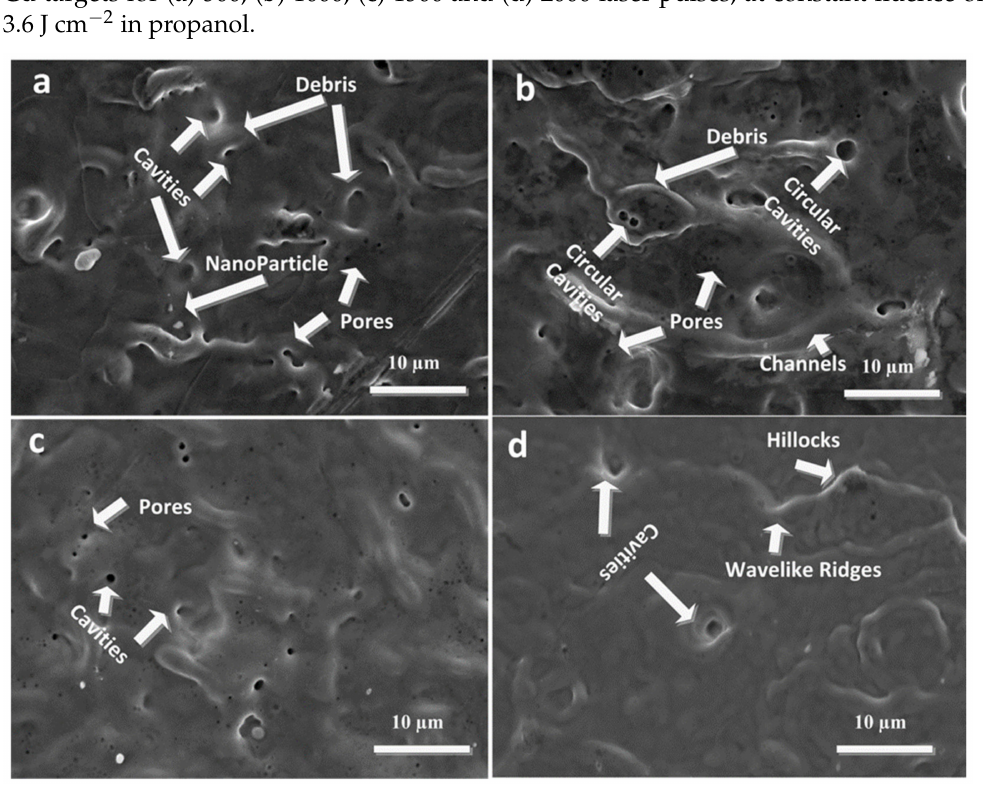
Figure 4. SEM topographical images at center of laser-ablated areas of cd targets using SEM analysis for ( a ) 500, ( b ) 1000, ( c ) 1500 and ( d ) 2000 laser pulses, at constant fluence of 3.6 J cm − 2 in